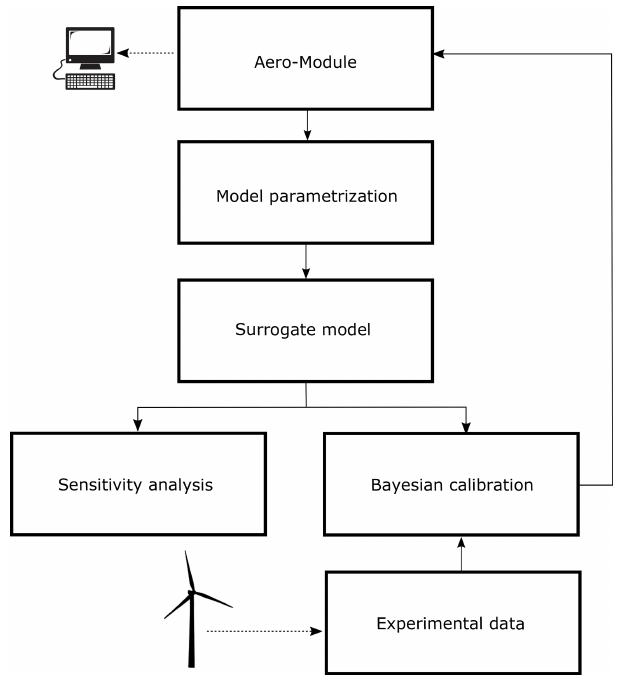
Figure 3. Flowchart for our Bayesian calibration